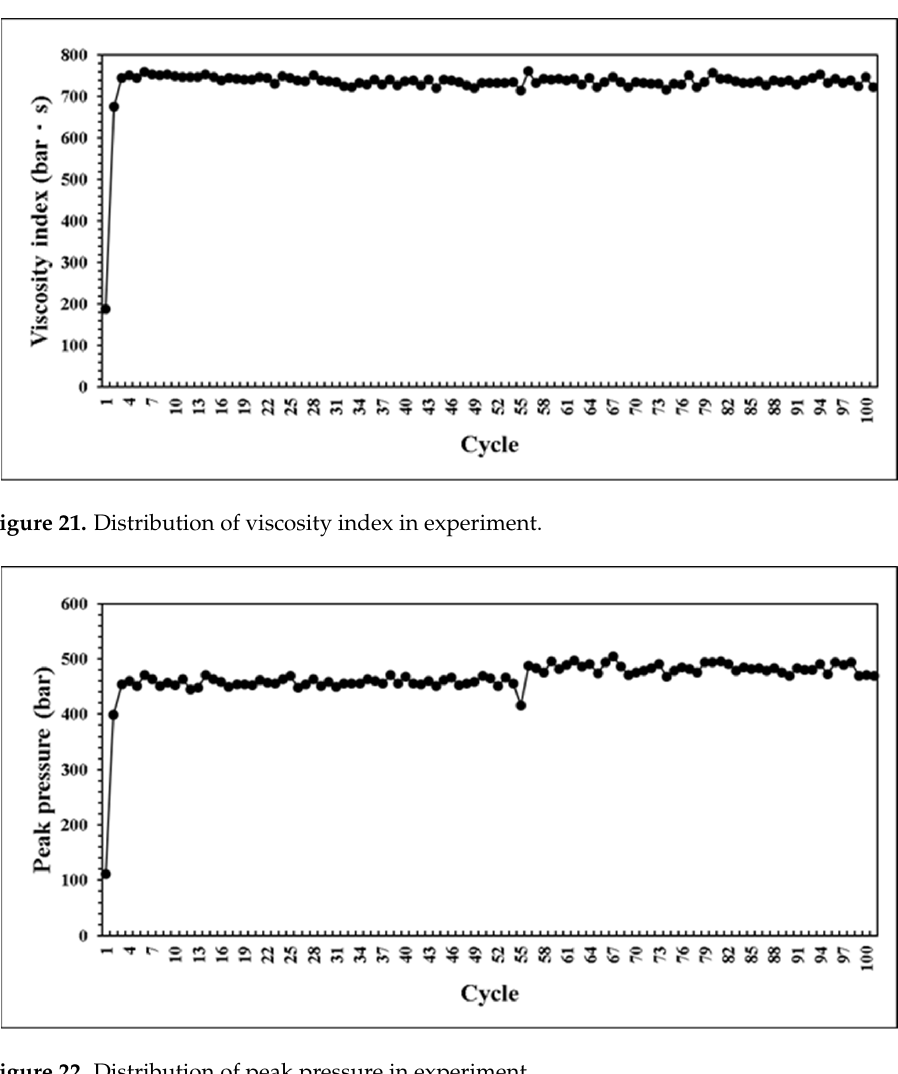
Figure 20. Adaptively adjust parameters results by adaptive control system.